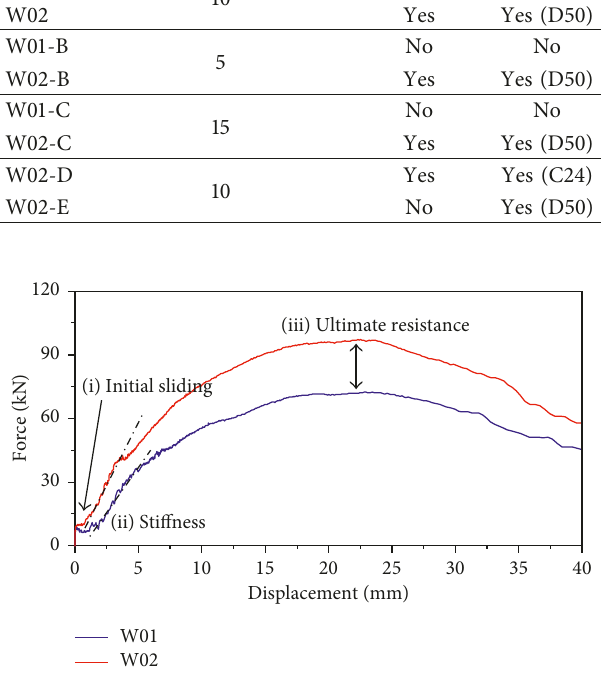
Figure 9: Load-displacement response of W01 and W02 log-haus assemblies